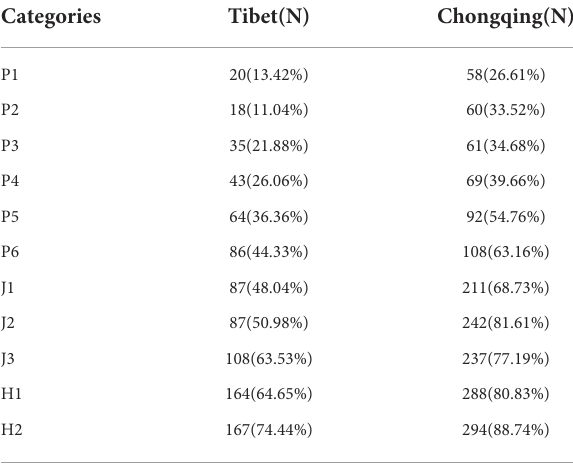
TABLE 1 Comparison of myopic rates according to grade for the students examined from Tibet and